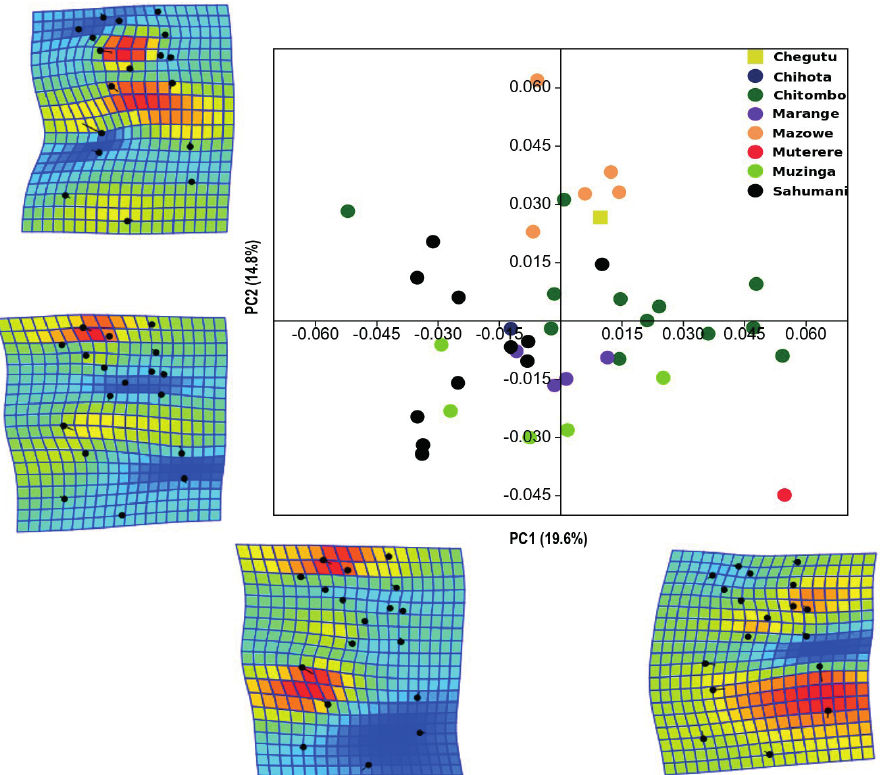
Figure 3. Principal component analysis of the first two PCs showing extremes of gonopod shape across eight populations of B. flavicollis. The thin plate spline deformation grids have been scaled up to illustrate shape differences along the respective PC